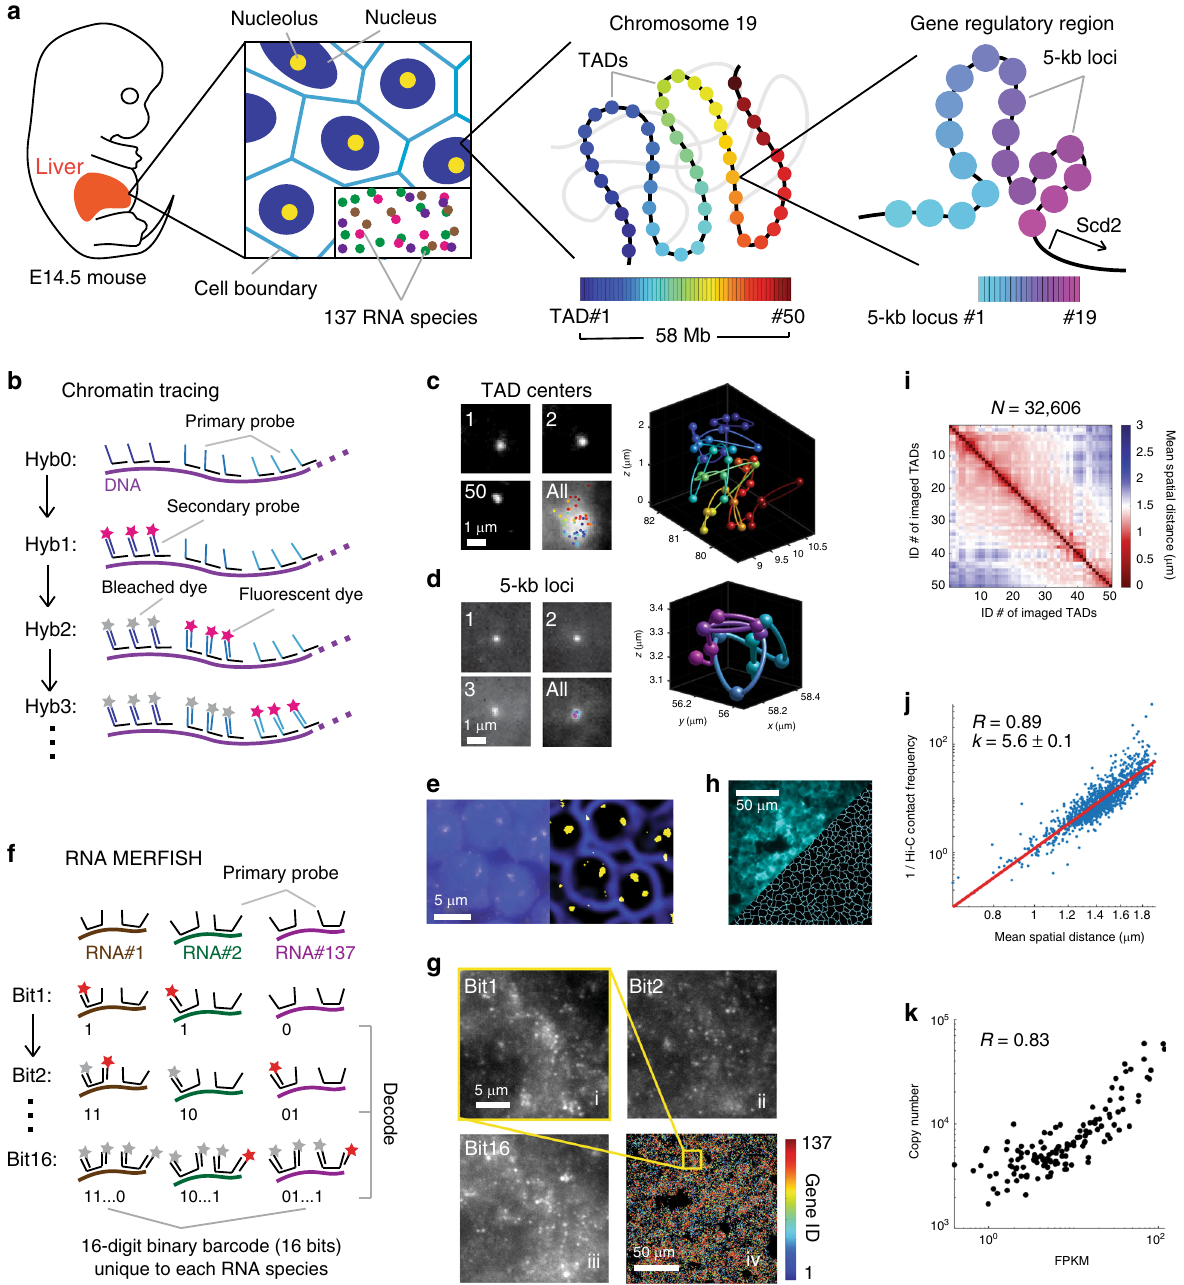
16-digit binary barcode (16 bits) unique to each RNA species Fig. 1 Mapping nucleome architectures in single cells of mammalian tissue. a Schematic illustration of the biological features measured by Multiplexed Imaging of Nucleome Architectures (MINA). We imaged cell boundaries, nuclei, nucleoli, 137 different RNA species, 50 TADs in chromosome 19 (Chr19), and 19 consecutive 5-kb loci upstream of gene Scd2 in E14.5 mouse fetal liver tissue sections. b A simpli fi ed scheme of the chromatin tracing approach. All genomic regions were fi rst labeled with primary probes (Hyb0), and then sequentially visualized with dye-labeled secondary probes (Hyb1, 2, 3 … ). c , d (Left panels) Individual and sum images of targeted TADs ( c ) or loci ( d ). Images are max projections along the z direction of the 3D image stacks. (Right panels) 3D positions of targeted regions plotted as pseudo-colored spheres connected with a smooth curve. e Raw (left panel) and processed (right panel) images of cell nuclei (blue) and nucleoli (yellow). f A simpli fi ed scheme of the RNA pro fi ling approach. Primary probes were fi rst hybridized to the RNA molecules, which encoded each RNA species with a unique 16-bit barcode. Then the barcode was decoded by sequentially visualizing the bits. g (i – iii) Images of RNA molecules in three rounds of secondary hybridization. Images are from a single z position in the 3D image stacks. (iv) All identi fi ed RNA molecules in a fi eld of view pseudo-colored based on their gene identities. The yellow boxed region is the same region shown in i – iii. h Raw (top left) and processed (bottom right) images of cell boundaries. i Mean spatial distance matrix of the 50 TADs, with each element showing the mean spatial distance between a pair of TADs. j Inverse Hi – C contact frequency versus mean spatial distance for each pair of TADs. Each dot represents a pair of TADs. k Total RNA copy numbers from imaging versus FPKM values from bulk RNA sequencing for each probed RNA species. Data from 137 RNA species were used to generate ( k ). Results in Fig. 1 are representative of four biological replicates. Source data are provided as a Source data fi